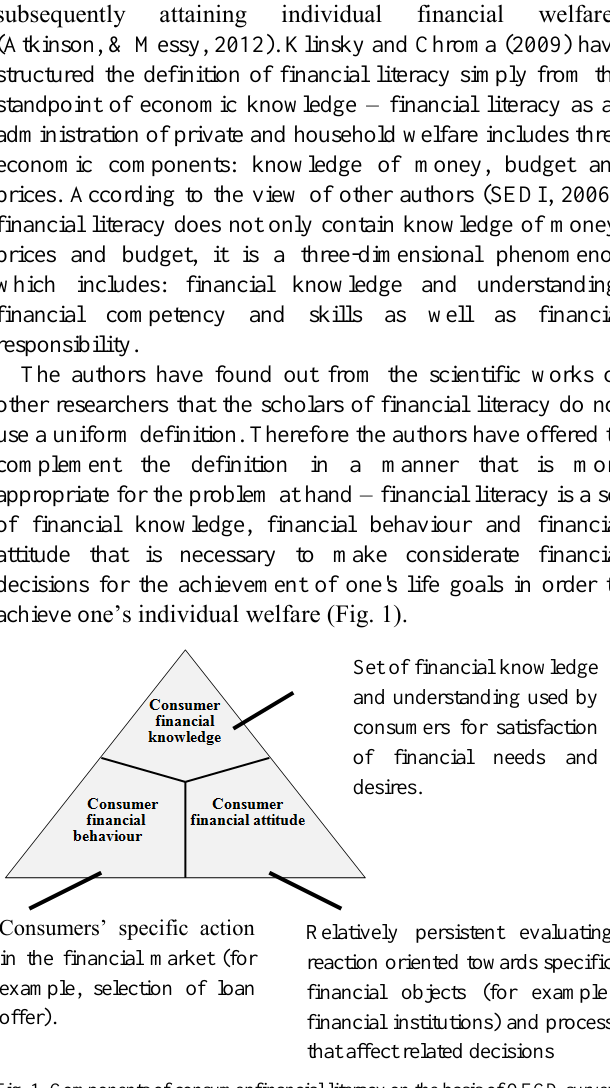
Fig. 1. Components of consumer financial literacy on the basis of OECD